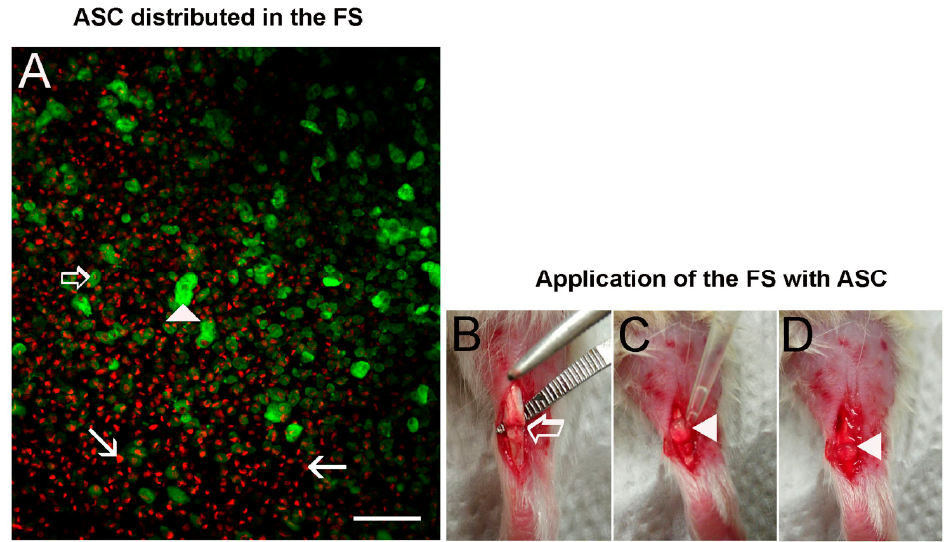
Figure 2. ( A ) Confocal microscope image of ASC labeled with phalloidin-FITC (actin cytoskeleton in green) and DAPI (nucleus in red) distributed in the dense fibrin network formed by the FS ( n = 3). Observe the disposition of 3.7 × 10 5 cells in the FS before application in the tendon transected region. ( (cid:183) ) superficial cells, ( ) intermediately positioned cells and cells at the bottom ( → ). ( B ) Model of tendon injury showing the partial transection ( ) in the proximal region of the Achilles tendon. ( C ) Application of the FS with ASC using a pipette: note the formation of a clot ( (cid:183) ). ( D ) Representation of the FS with ASC ( (cid:183) ) covering the transected region before the skin suture. Bar = 200 µ m.